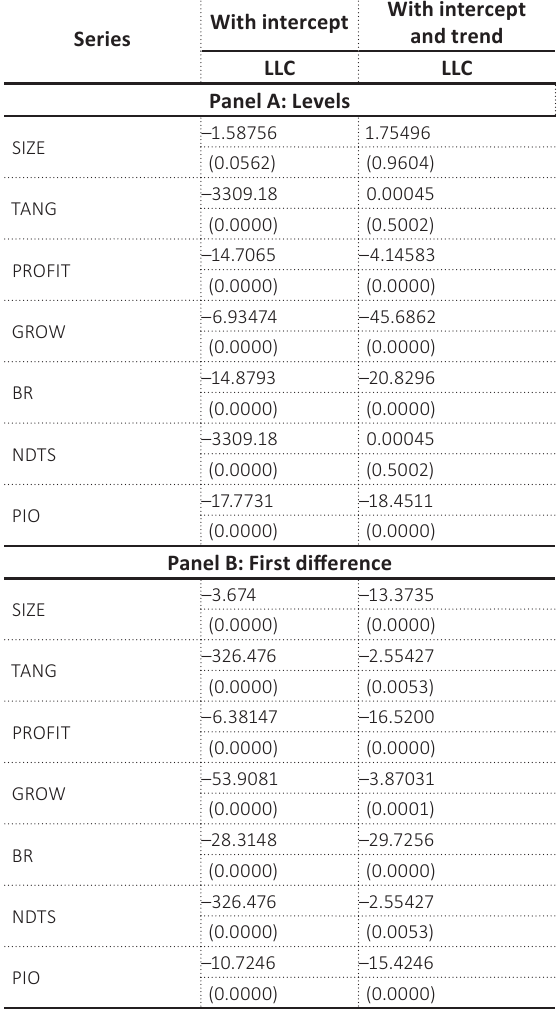
Table 4 details the results of the capital